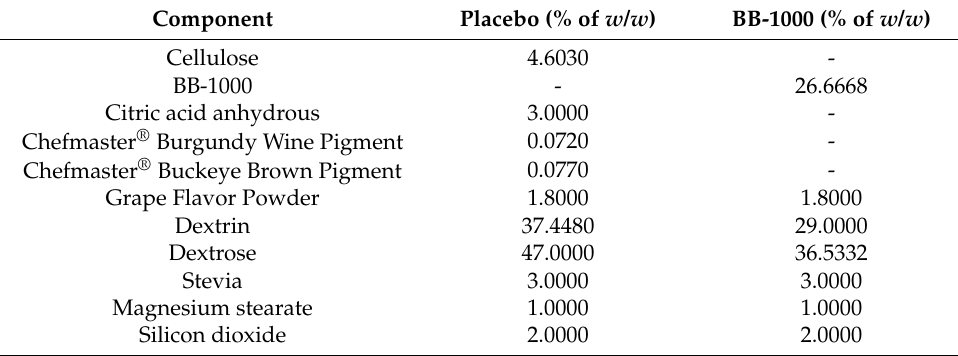
Table 1. Formulation of BB-1000 and